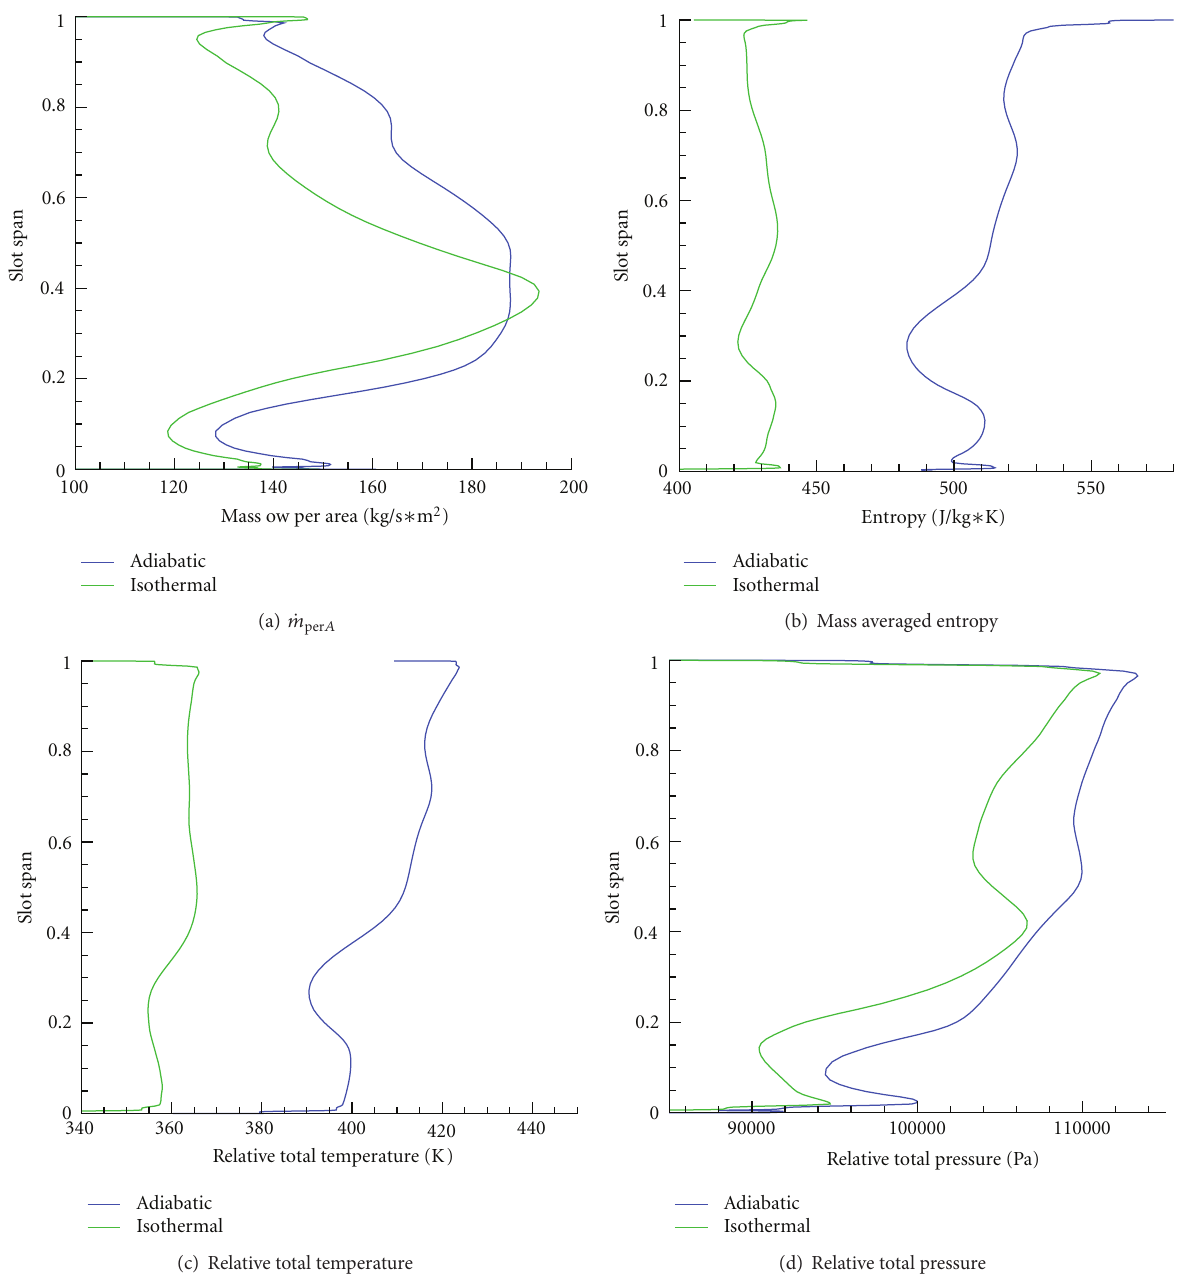
F 12: Time-averaged spanwise distributions of several quantities at the slot inlet. Mass averaged across the slot width at each spanwise